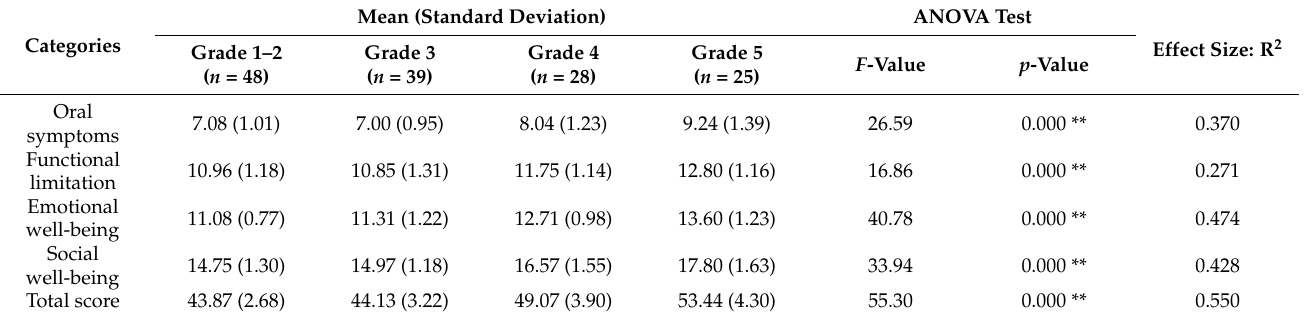
Table 5. Inferential analysis. Variables of the CPQ-Esp 11–14 questionnaire based on the IOTN ( n =